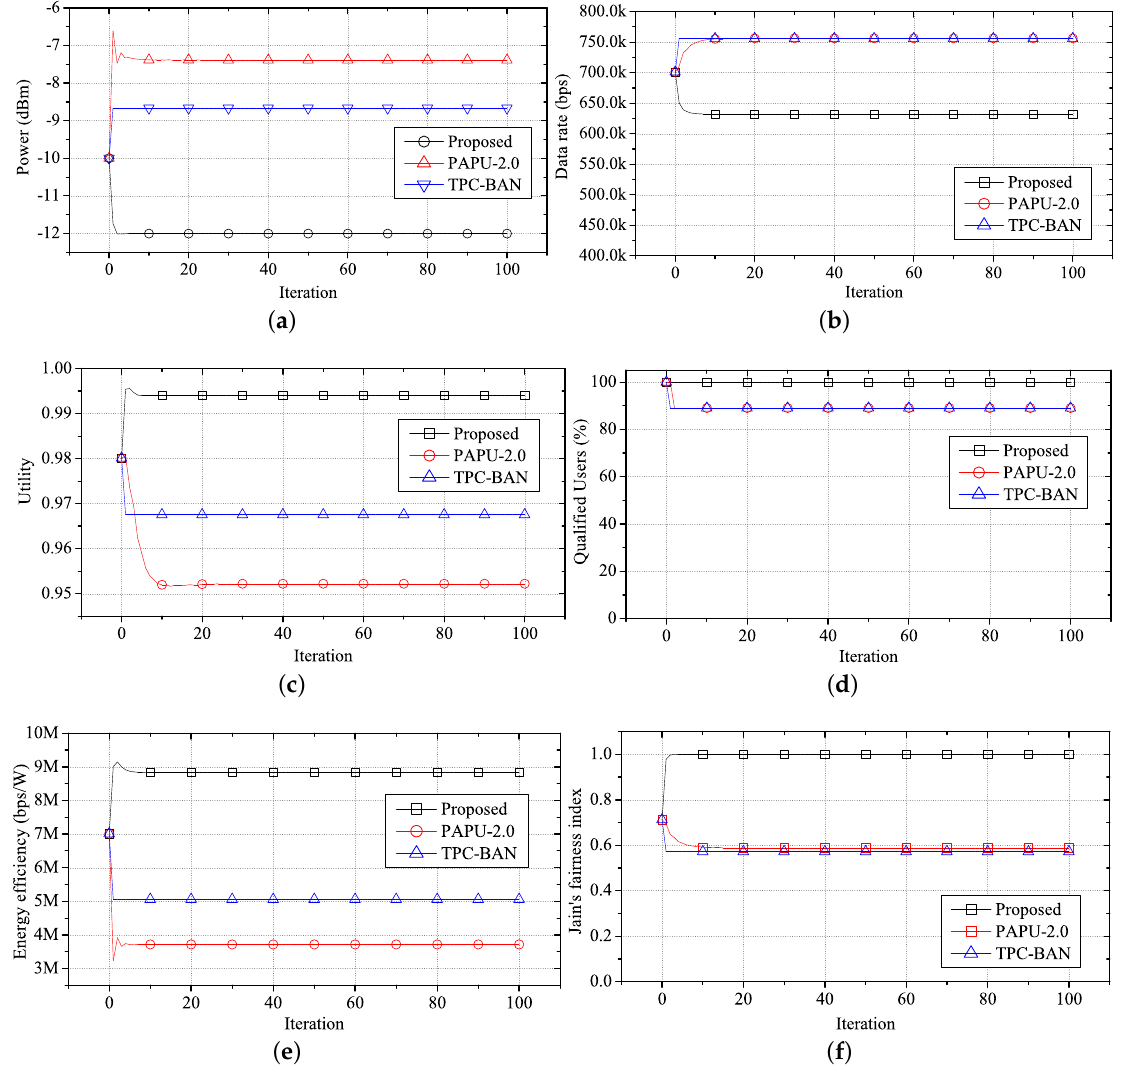
Figure 10. Performance of FTPC-U compared with PAPU and TPC-BAN over time. ( a ) Change in average transmit power over time; ( b ) change in average data rate over time; ( c ) change in average utility over time; ( d ) change in qualified users over time; ( e ) change in average energy efficiency over time; ( f ) change in fairness over time. PAPU, proactive power update; TPC-BAN, transmission power control for body area